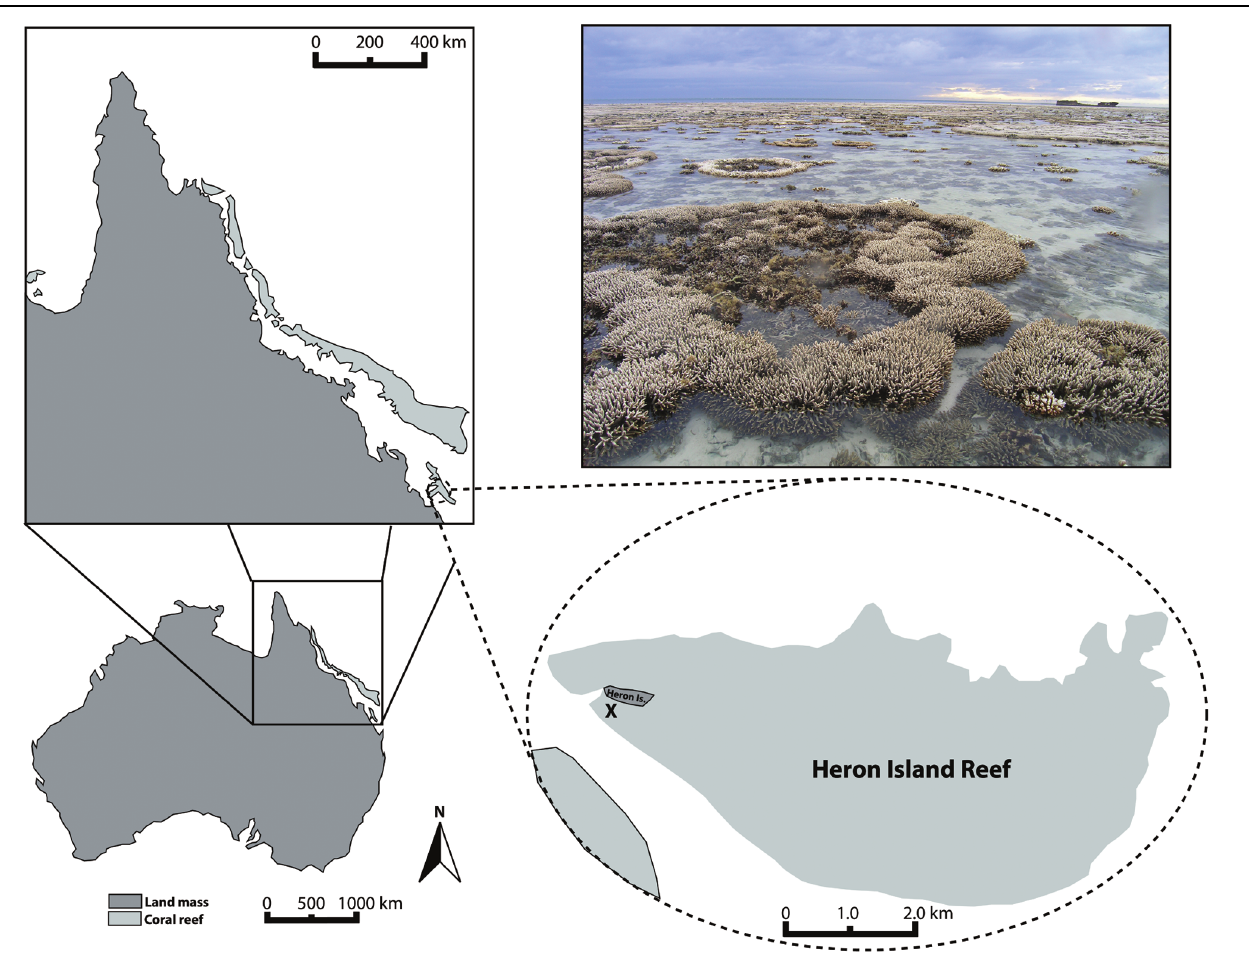
FIGURE 1 | Map of Heron Island tidal flat (Great Barrier Reef, Australia) indicating the location from which experimental coral colonies were collected (X). Photograph of tidal flat exemplifies the partial aerial exposure and associated patchy bleaching that many corals experienced in March 2011, prior to and in conjunction with the collection of experimental coral